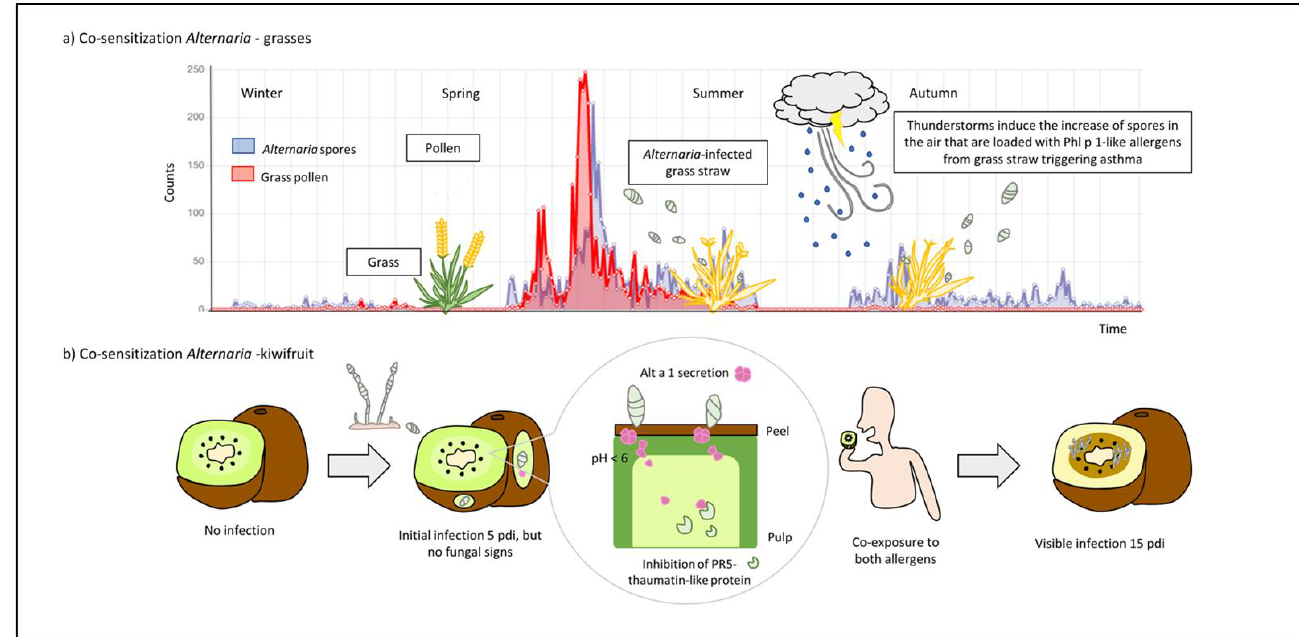
Figure 3. Co-sensitization phenomena between Alternaria and other allergens: ( a ) asthma exacerbation by sensitization to Alternaria grass pollen. In Central Spain, grass pollen patients suffer from asthma during late summer and early fall, when pollen is no longer present. In contrast, in this season, Alternaria spore peaks were registered (data from Ciudad Real, 2020, SEAIC, https://www.polenes.com/es/home). Considering that thunderstorms and grass postharvest are common at this time, the authors described the role of spores as Group-1 grass allergen carriers and suggested that the inhalation of loaded spores may be the cause of the asthma exacerbations in grass pollen patients; ( b ) Alternaria , kiwifruit co-sensitization. Alternaria infects kiwifruits secreting Alt a 1 that can be detected in pulp at 5 days post infection (dpi) while fungal hypha is not visible. The partial inhibition of a PR5 thaumatin-like protein (Act d 2) by Alt a 1 was reported, evidencing the role of the fungal protein in plant pathogenesis, and providing an explanation for the co-relation between Alt a 1 and Act d 2 sensitizations as a result of consumption of Alternaria -infected kiwifruits but apparently in good conditions.